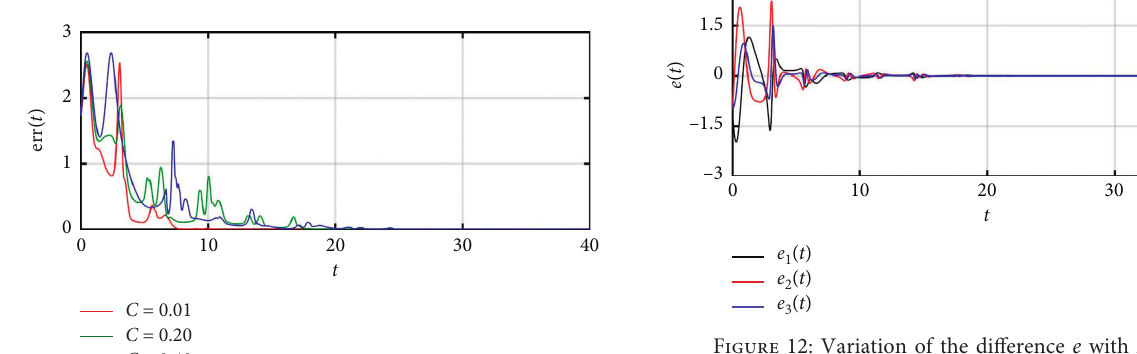
Figure 12: Variation of the difference e with R �